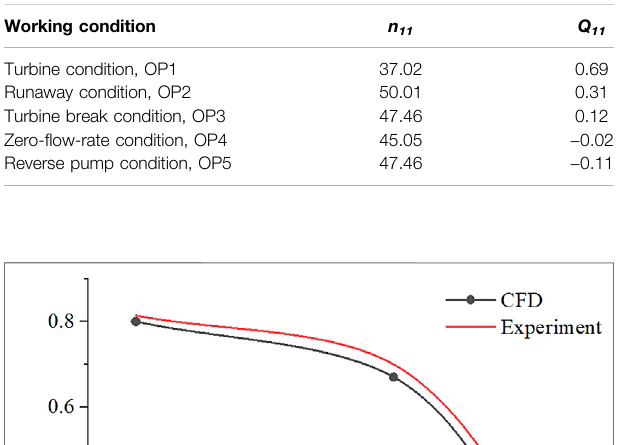
TABLE 3 | Calculated working points.